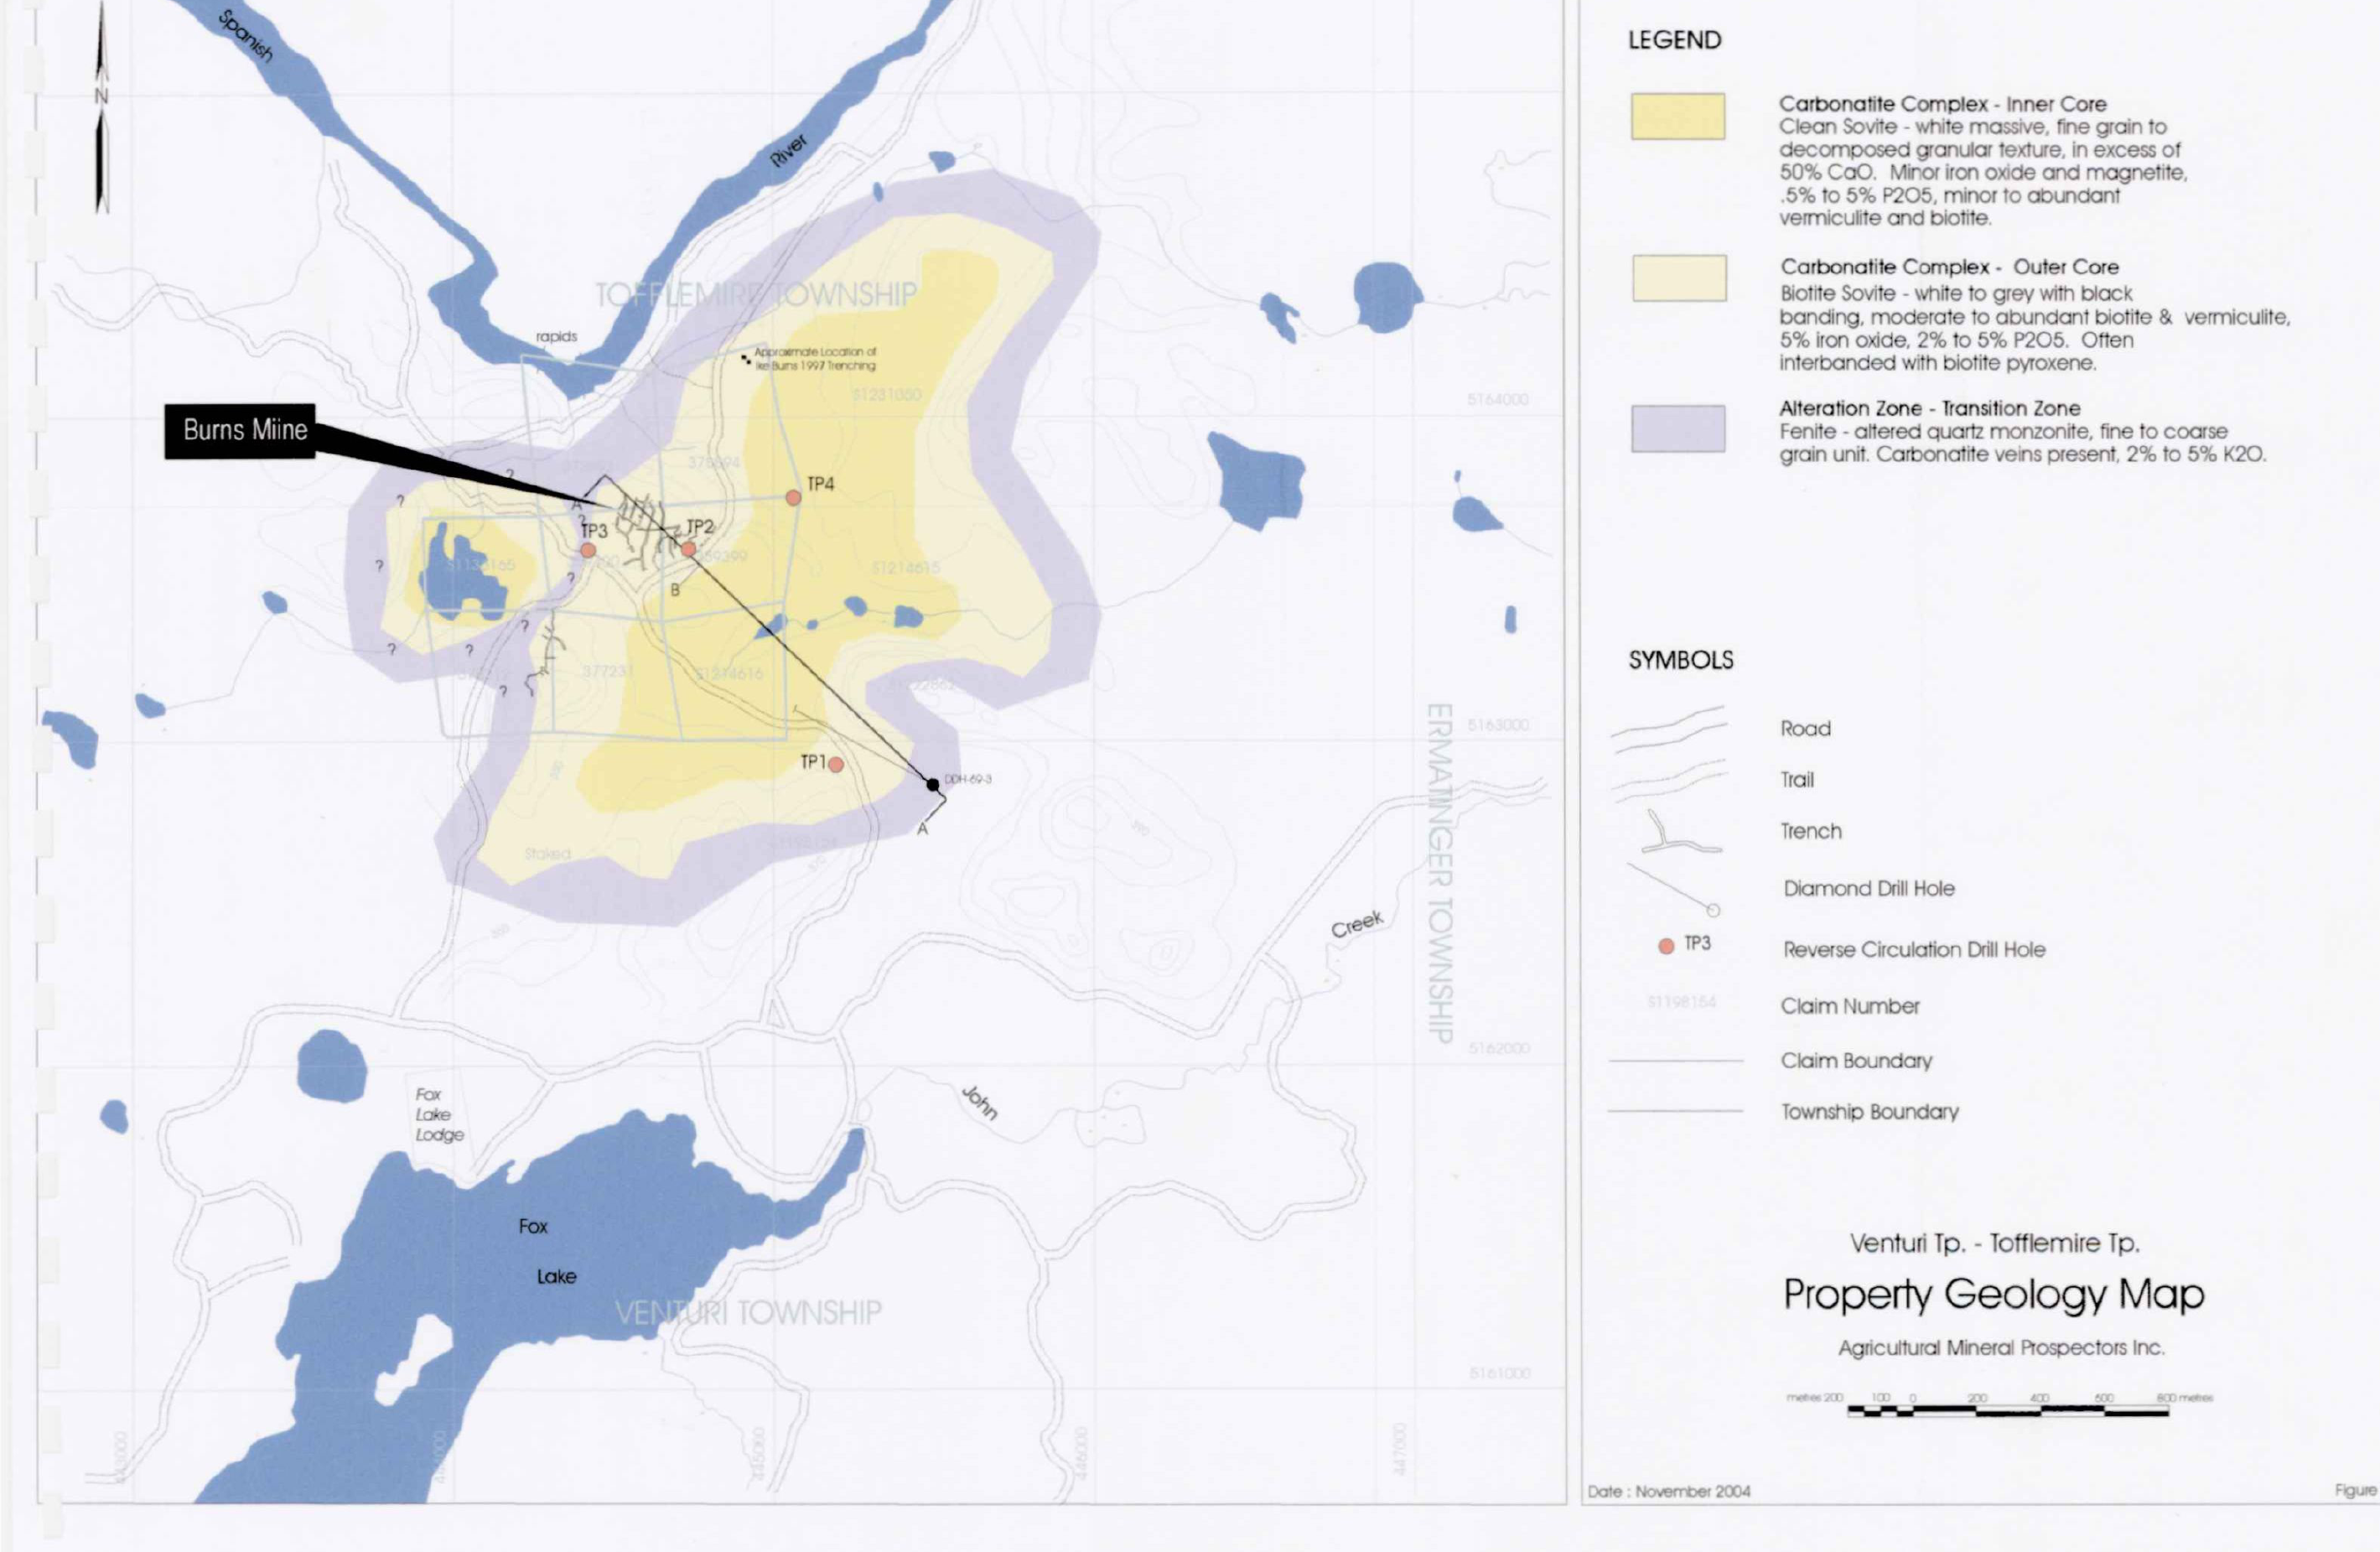
Venturi Tp. - Tofflemire Tp. Property Geology Map Agricultural Mineral Prospectors